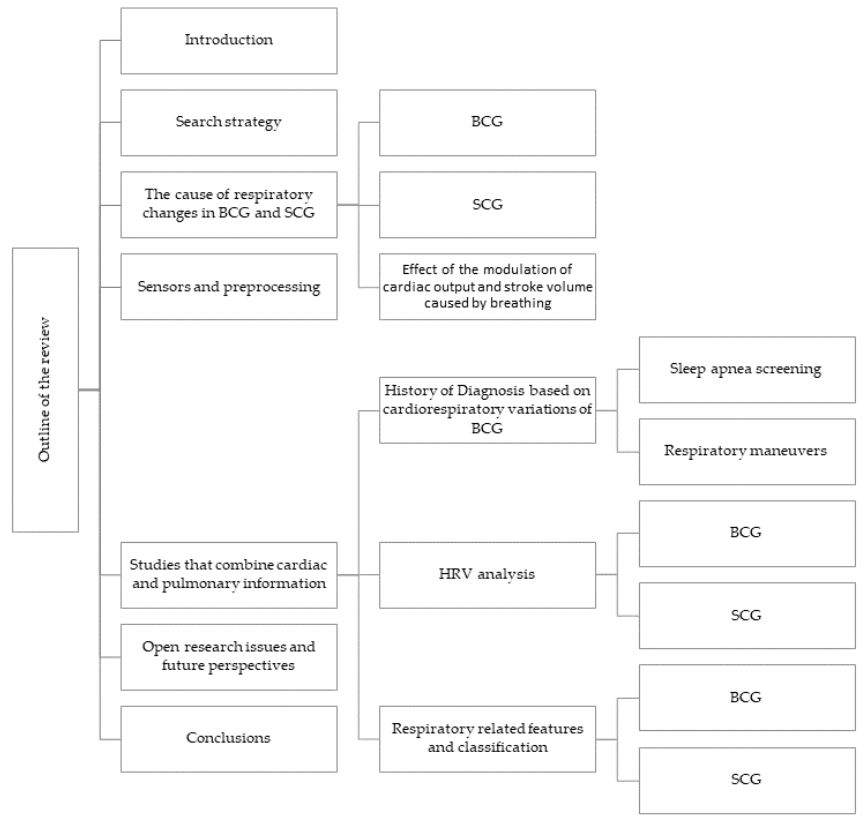
Figure 3. Outline of the review. Table 1. Comparison of existing reviews in the field.